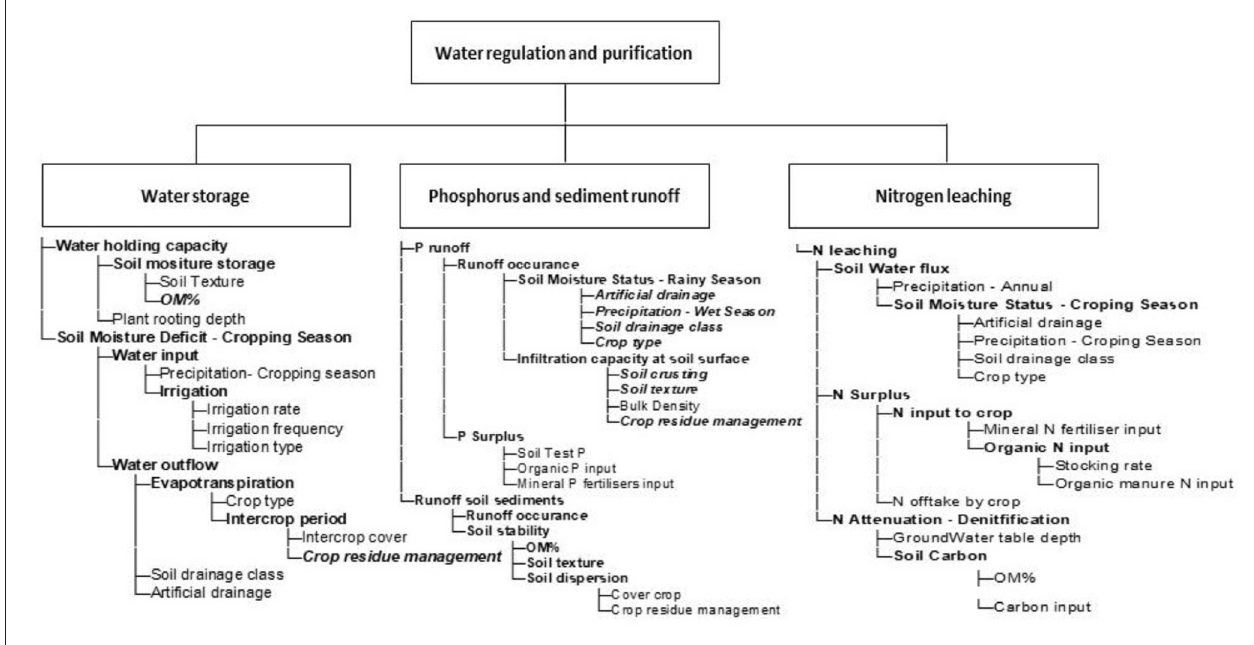
FIGURE 2 | The decision support model for water regulation and purification (WR) that is built up from basic attributes via aggregated attributes to the ultimate soil function, water regulation and